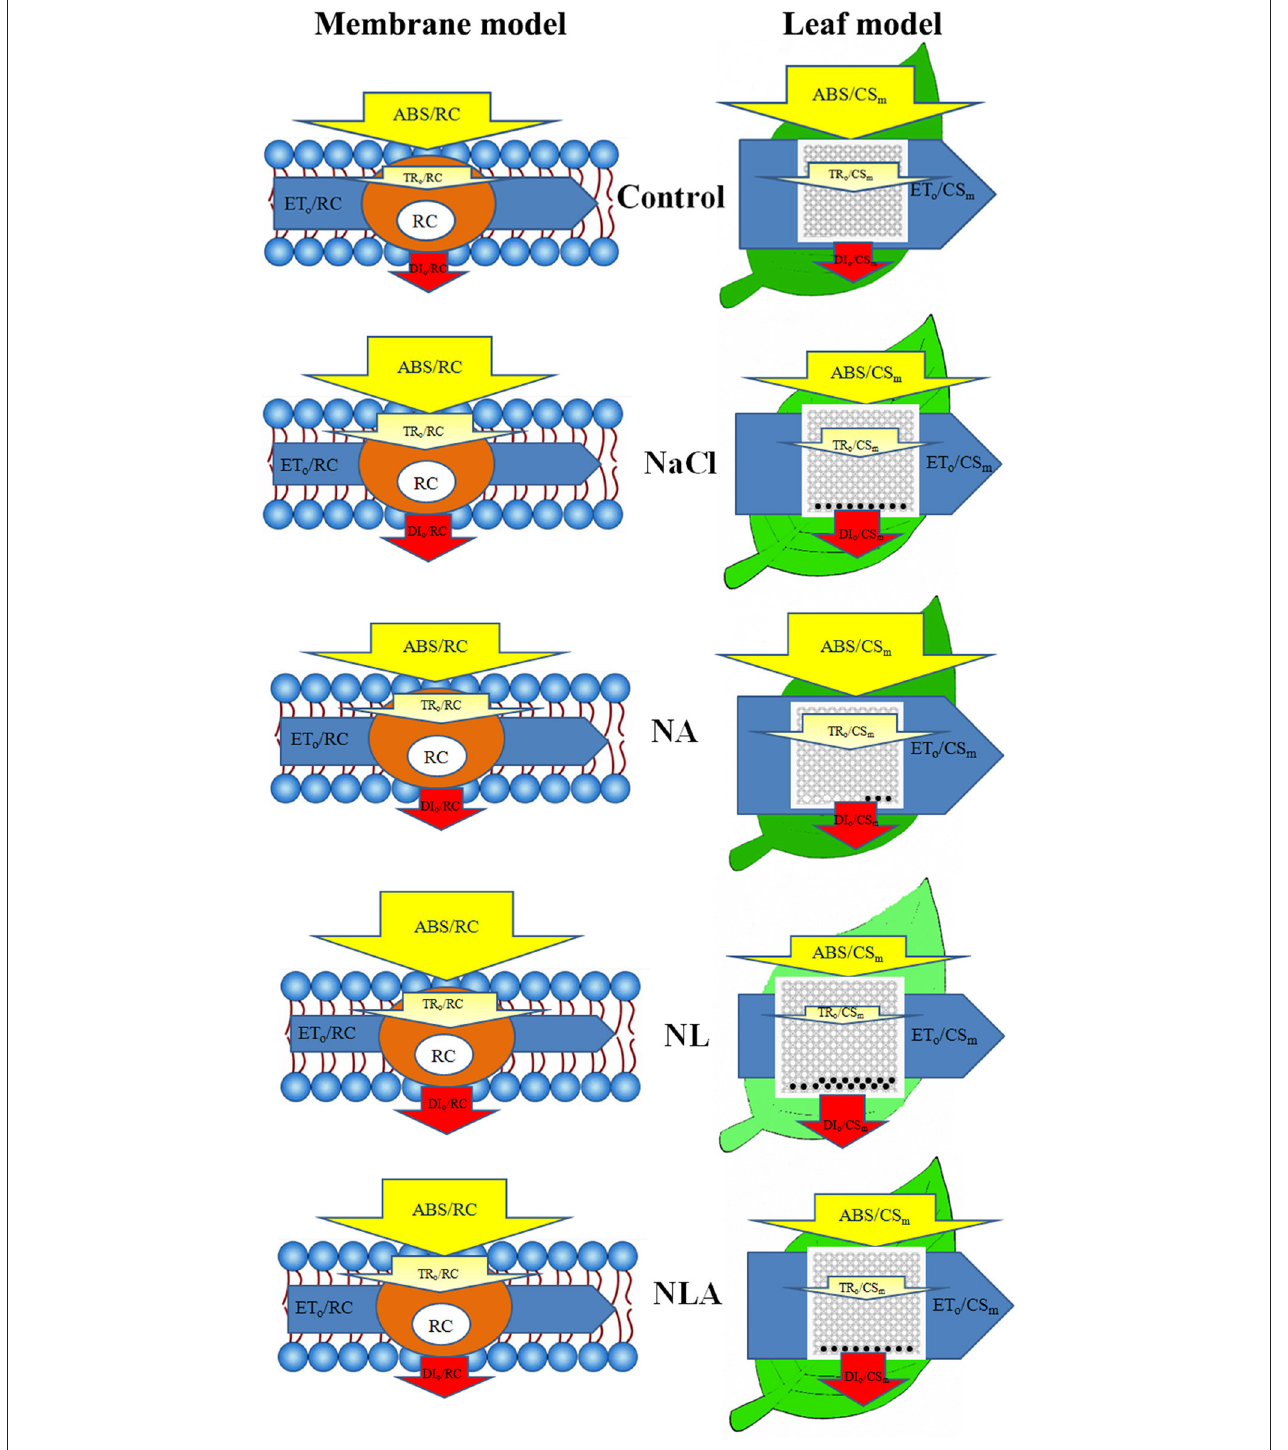
FIGURE 10 | Energy pipeline models of specific fluxes per reaction center (RC) and phenomenological fluxes per excited cross-section (CS m ) in the member (left) and the leaf (right) of salt-stressed tomato seedling with or without exogenous ascorbic acid (AsA) and lycorine (LYC) spraying. In the member and leaf models, ABS, TRo, ETo, and DIo indicate absorption, maximum trapping flux beyond Q A , electron transport, and dissipation flux, respectively. In the leaf models (right), the leaf color represents the pigment concentration, and the active and inactive RCs are indicated by open circles and closed circles, respectively. The detailed calculation of each parameter is given in Table 1 . Control, no added NaCl, no sprayed AsA and LYC; NaCl, added 100 mmol/L NaCl; NA, added 100 mmol/L NaCl and sprayed 0.5 mmol/L AsA; NL, added 100 mmol/L NaCl and sprayed 0.25 mmol/L LYC; NLA, added 100 mmol/L NaCl and sprayed 0.25 mmol/L LYC and 0.5 mmol/L AsA.